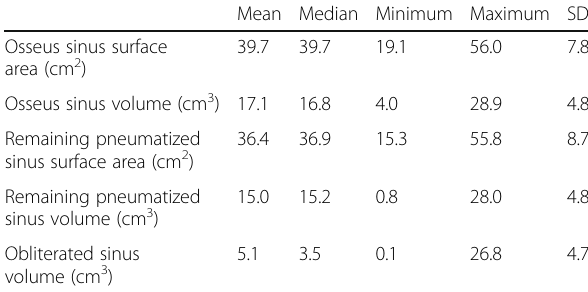
Table 1 Mean, median minimum, maximum, and standard deviation of the surface in square centimeter and volume in cubic centimeter of the osseus maxillary sinuses and the remaining pneumatized cavities in cases of obliterated sinuses as well as mean, median, minimum, maximum, and standard deviation of the calculated obliterated sinus volume in cubic